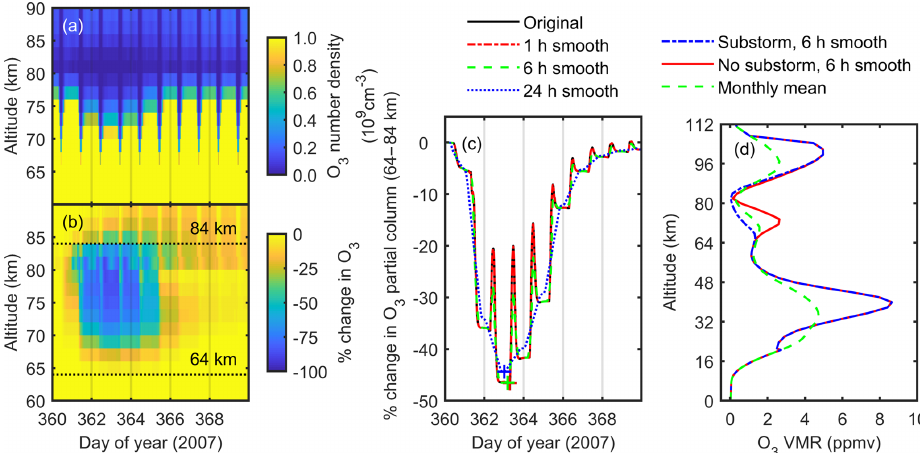
Figure 2. Derivation of ozone (O 3 ) volume mixing ratio profiles from atmospheric model datasets. Panel (a) shows O 3 number densities calculated by the SIC model for December 2007 substorm conditions at Kilpisjärvi (69 ◦ 03 (cid:48) N, 20 ◦ 48 (cid:48) E), Finland. Panel (b) shows the percentage change in modelled O 3 abundance from background (no substorm) conditions. Panel (c) shows the percentage change in O 3 partial column over altitudes 64–84km during substorm conditions for the original (15 min) model resolution and 1, 6, and 24h smoothed data. “ + ” symbols indicate the largest decreases in O 3 partial column at each nominal time resolution. Panel (d) shows the 6h smoothed O 3 VMR profiles for December substorm, background (no substorm), and monthly mean